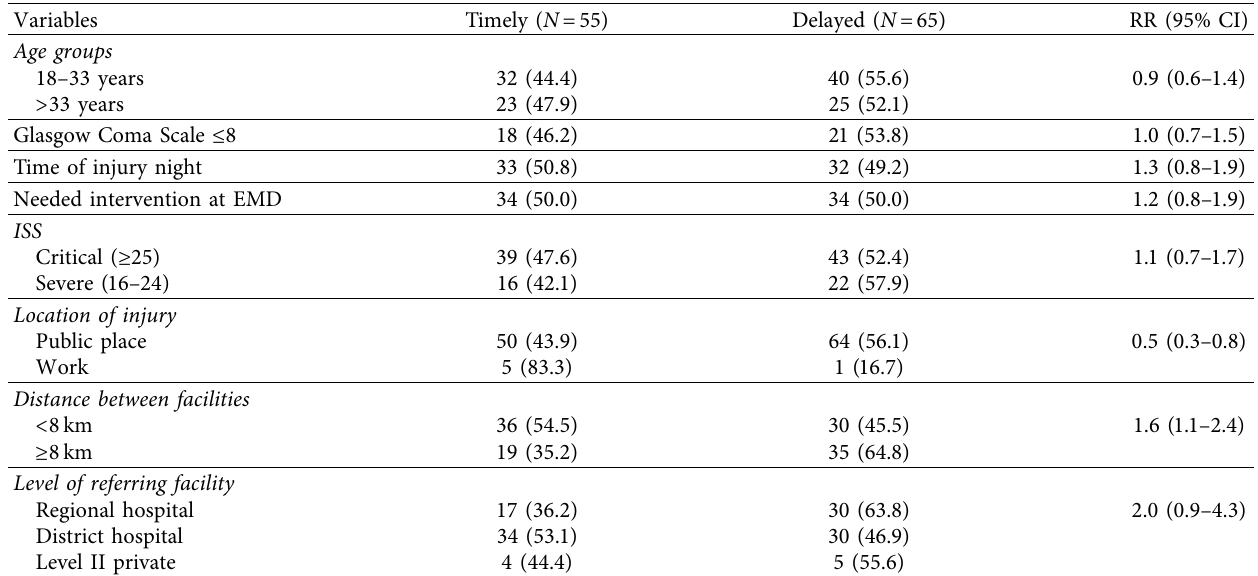
Table 3: Factors associated with timely presentation of referral polytrauma patients who presented to the EMD-MNH, Dar es Salaam, Tanzania.